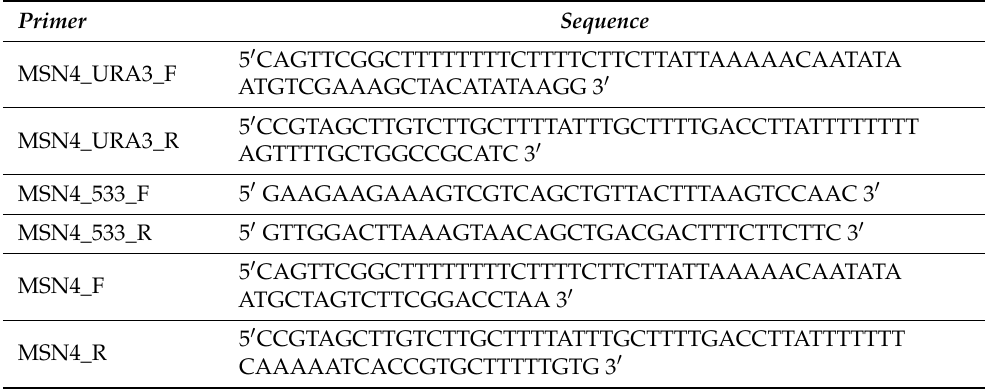
Table 2. Primers used for the generation of MSN2 and MSN4 mutants.